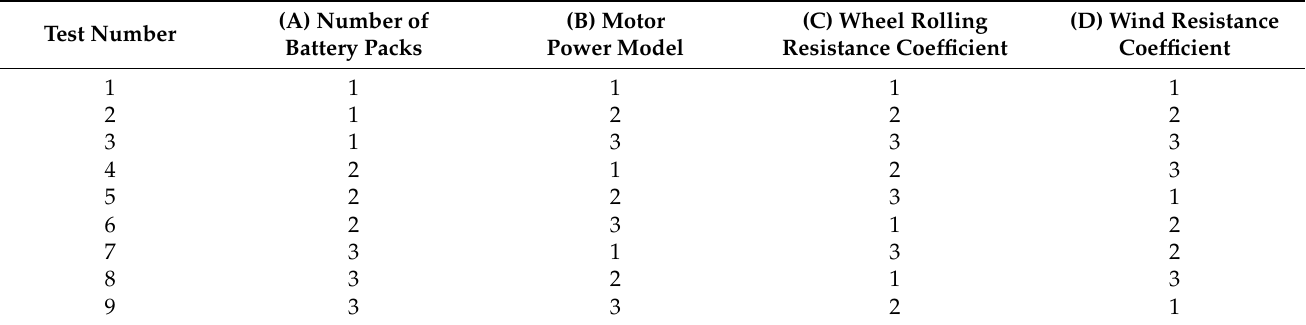
Table 8. Orthogonal experimental table.